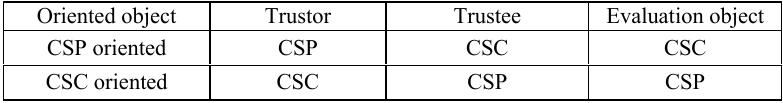
Table 2. Overall classification of trust models in cloud